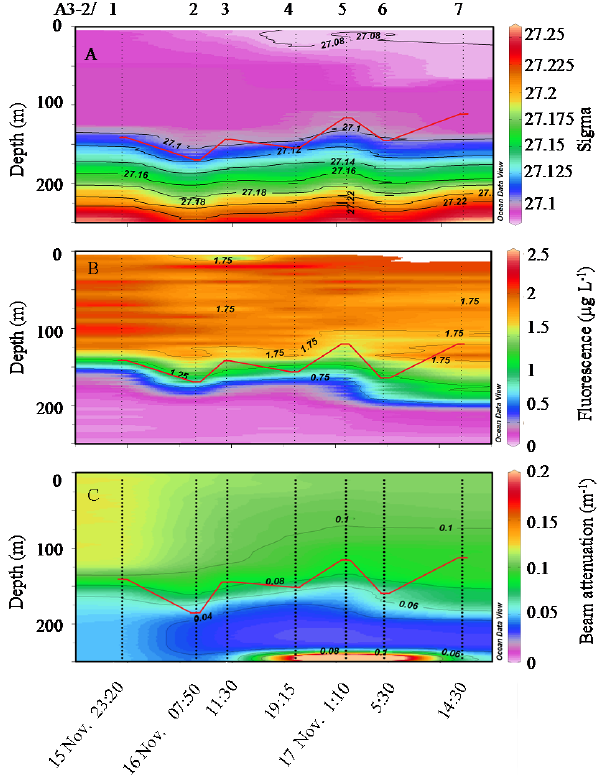
Figure 2. Temporal evolution of density (A) , fluorescence (B) , and turbidity (C) during the spring survey. The red line shows the mixed layer depth.